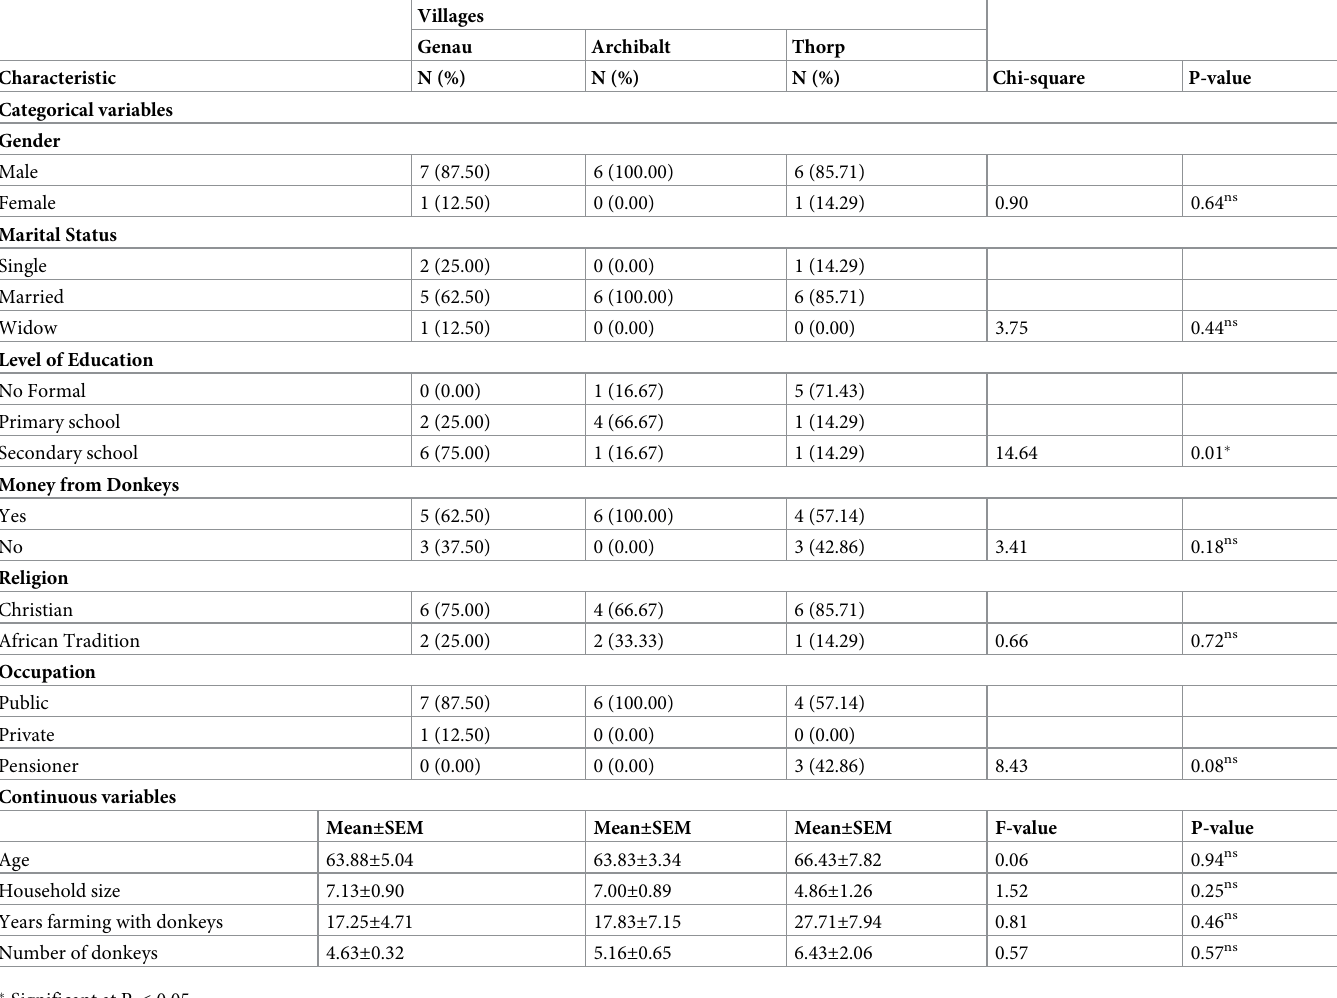
Table 1. Socio-economic status of donkey